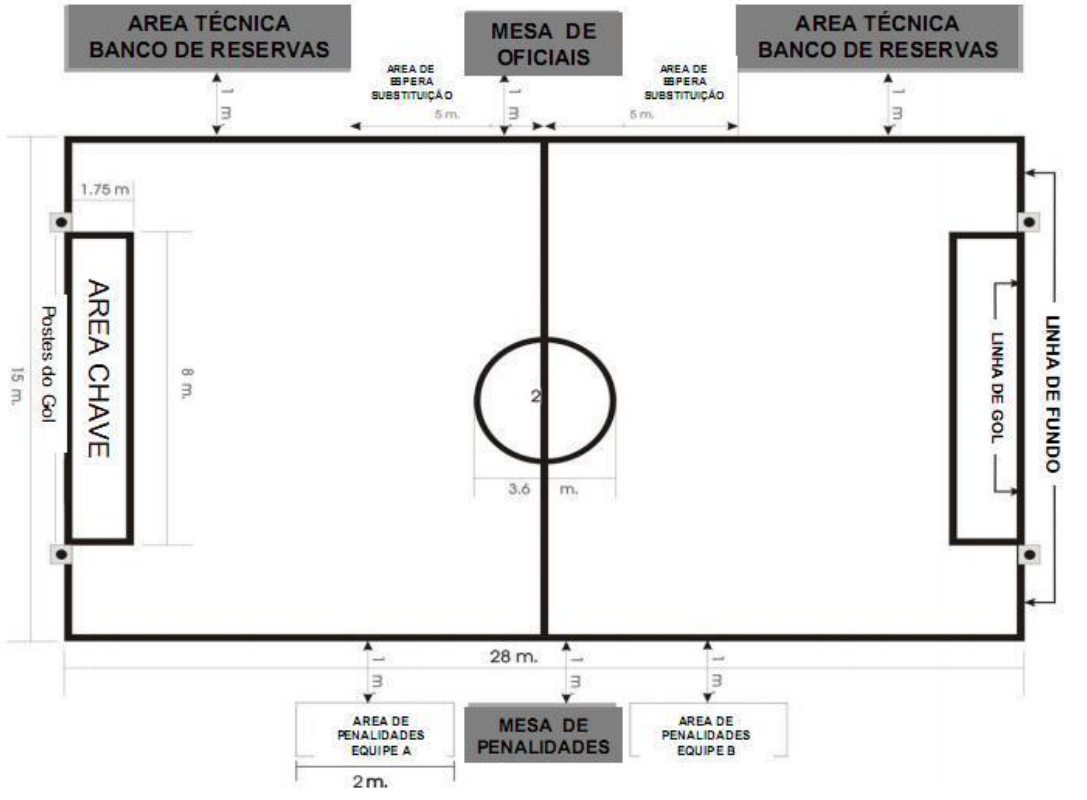
Figura 1. A quadra do Rugby em Cadeira de